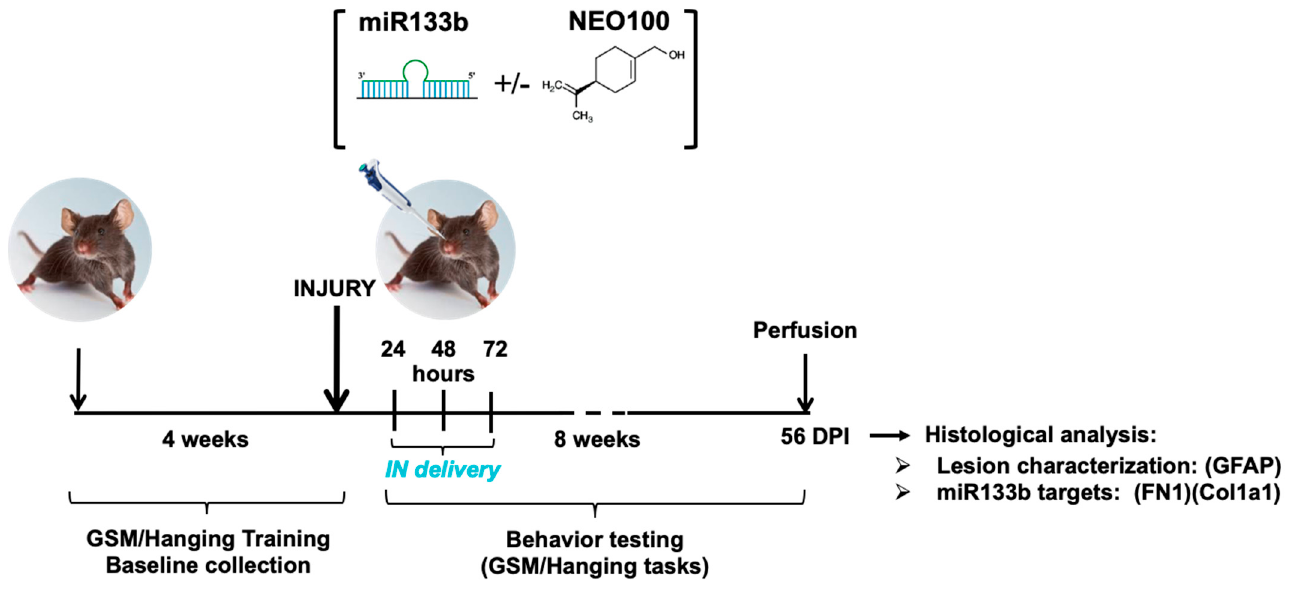
Figure 1. Schematic representation of the experimental design. Mice were trained for gripping and grasping tasks for 4 weeks followed by the baseline collection. At 24 h post − injury, mice received the intranasal delivery of either miR133b/Ago2 alone or miR133b/Ago2 with NEO100 for 3 consecutive days. The control groups received scrambled − miR alone with or without NEO100, NEO100 alone and Vehicle alone. The behavior testing was performed for 8 weeks post-SCI. At the end of all testing, mice were euthanized, spinal cords dissected and further analyzed for lesion identification (GFAP staining), fibronectin (FN1) and Collagen1 type 1 (Col1a1) protein expression. DPI = days post − injury.